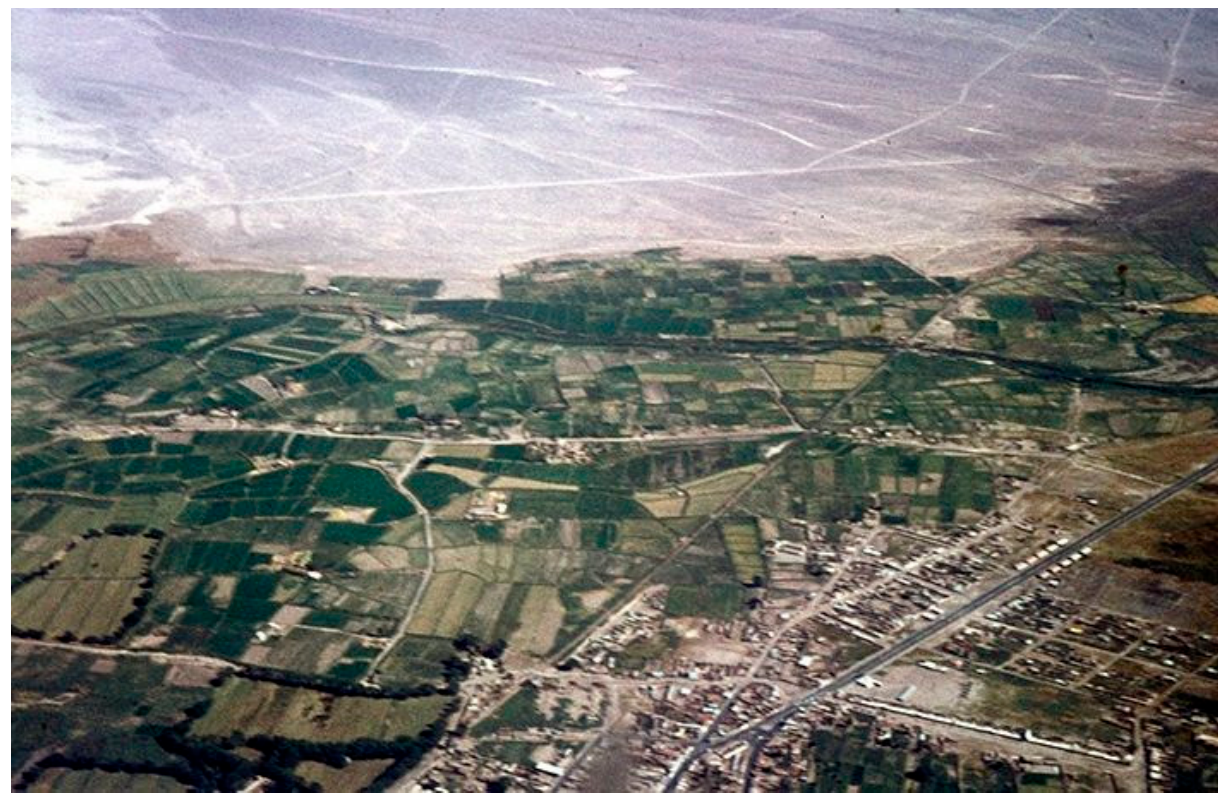
Figure 5. Aerial view of Calama in 1966. Source: National Historical Museum Collection (Author: Anonymous).